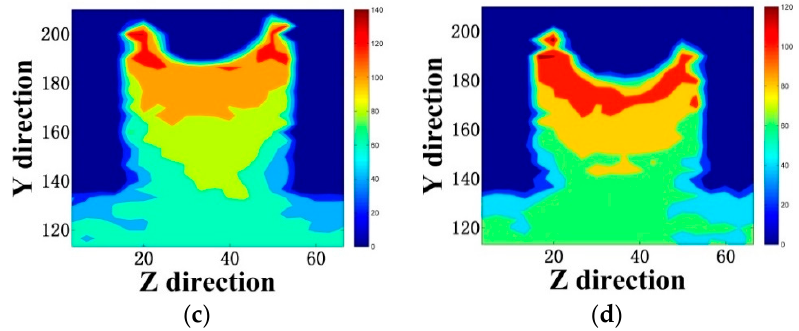
Figure 5. Displacement color map of ( a ) a pure aqueous solution, ( b ) 0.3 mol/L emulsion, ( c ) 0.6 mol/L emulsion, and ( d ) 0.9 mol/L emulsion. (The unit in the Y and Z directions is Å).